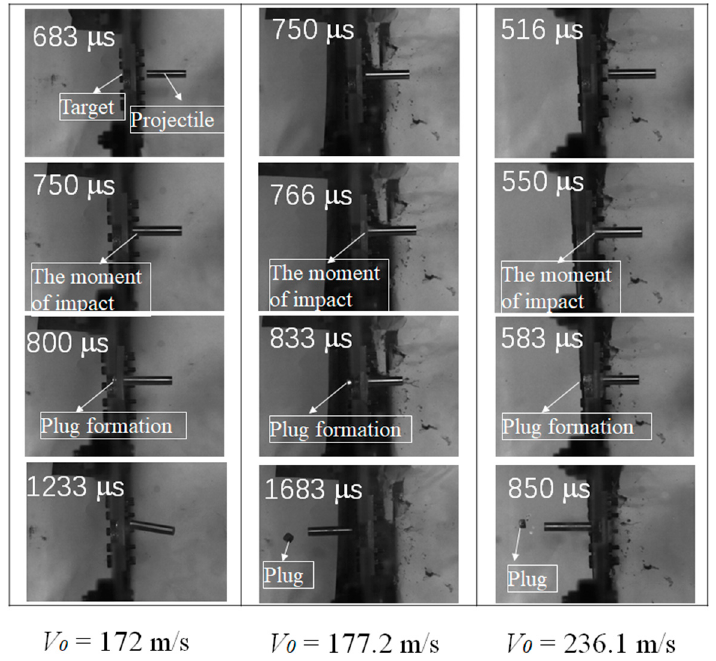
Figure 5. The impact process recorded by the high-speed camera.